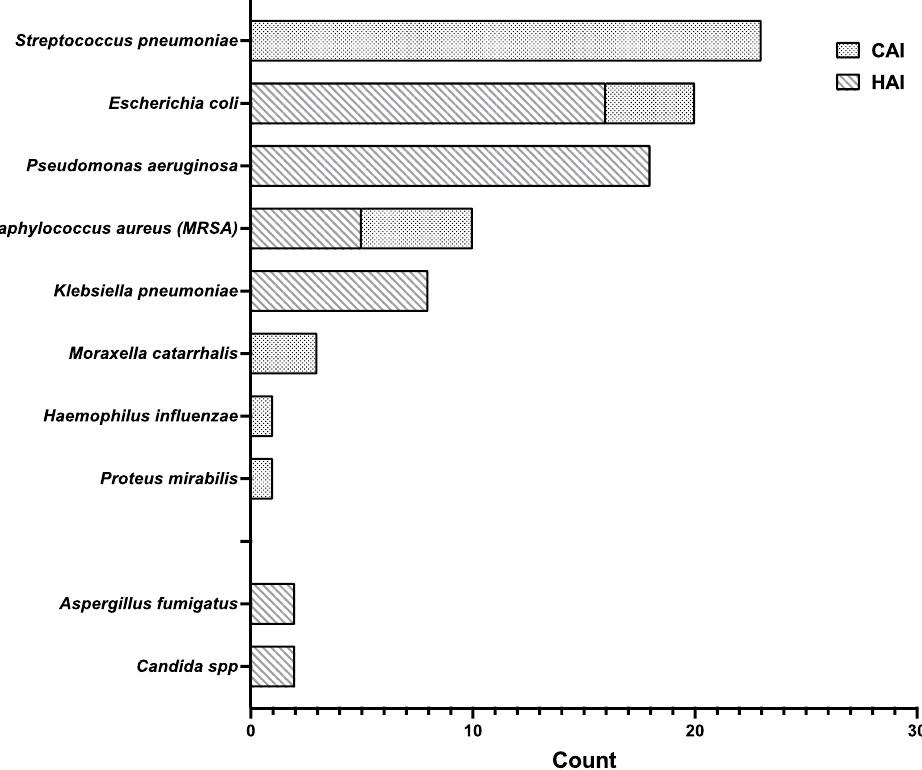
Figure 1. Etiology of bacterial and fungal infections, differentiated by their origin. Community- acquired infections (points) are only bacterial in etiology, while hospital-acquired infections (stripes), more frequent than CAIs, are both bacterial and fungal. Abbreviations: MRSA, methicillin-resistant Staphylococcus aureus ; CAI, community-acquired infection; HAI, hospital-acquired